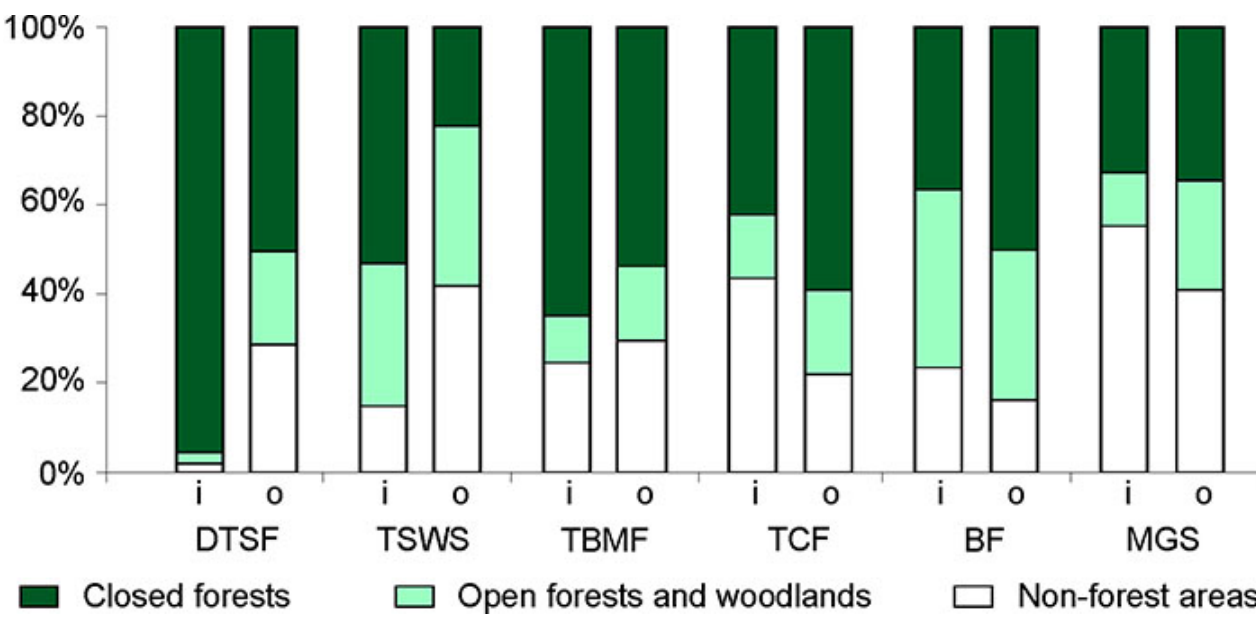
Fig. 3. Tree canopy density inside IFL (i) and outside IFL (o) for different biomes (DTSF - Dense Tropical and Subtropical Forest; TSWS - Tropical and Subtropical Woodland and Savanna; TBMF - Temperate Broadleaf and Mixed Forest; TCF - Temperate Coniferous Forest; BF - Boreal Forest; MGS - Montane Grassland and